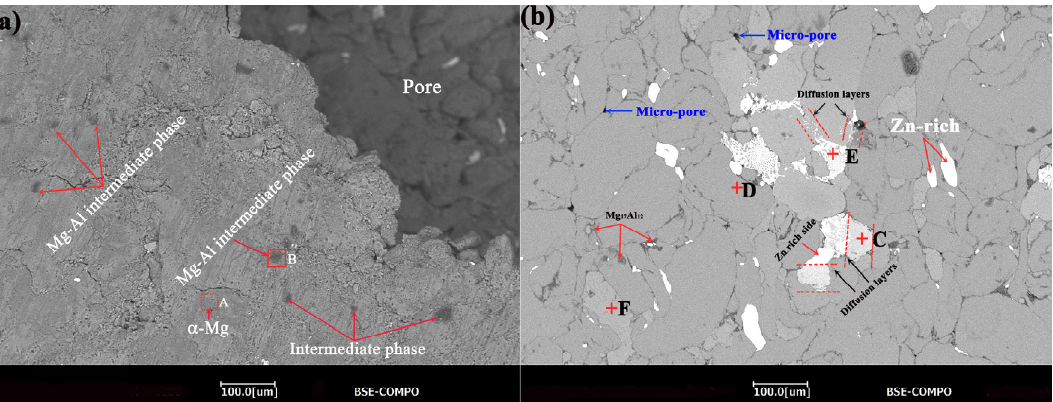
Figure 8. SEM image of the cell wall of the porous Mg-9Al-1Zn alloy foam ( a ) and SEM image of the cell wall of the porous Mg-9Al-5Zn alloy foam ( b ). The EDS analysis results marked as “A” to “F” are listed in Table 3.